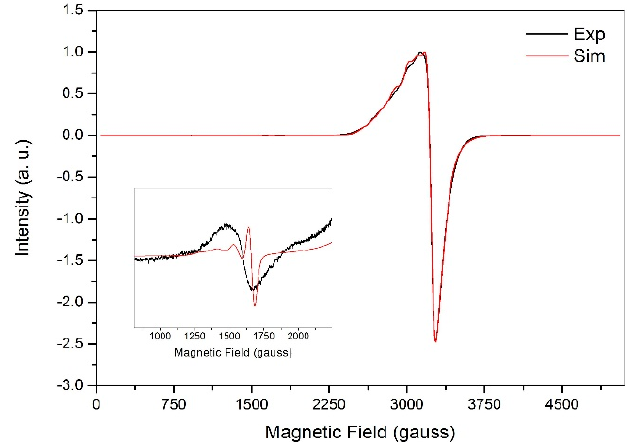
Figure 3. X-band EPR spectra for solid 1 (ground crystals) at 77 K with amplification (inset) for the half-field transition. Experimental spectrum in black and simulated spectrum in red. Table 2. EPR spectrum simulation parameters for the frozen solution and solid powder spectra at 77 K.